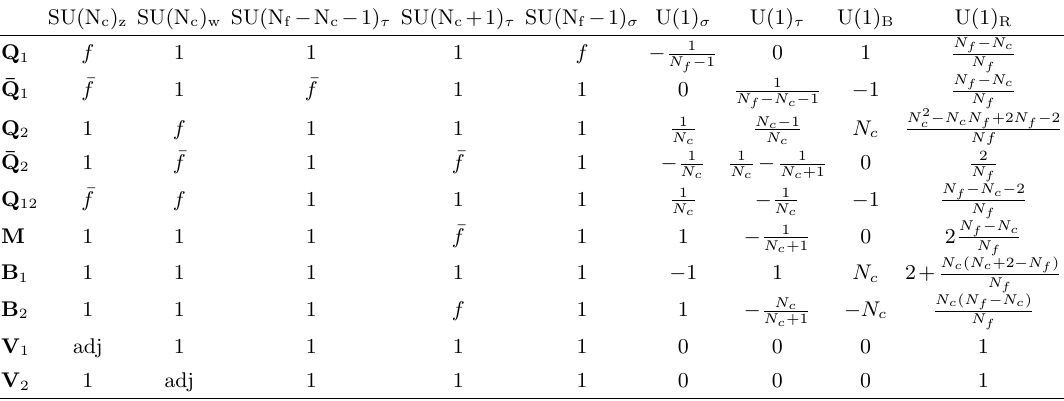
Table 3 . The matter content of the quiver gauge theory whose (cid:12)eld content corresponds to the superconformal index I quiver ; S given by eq.